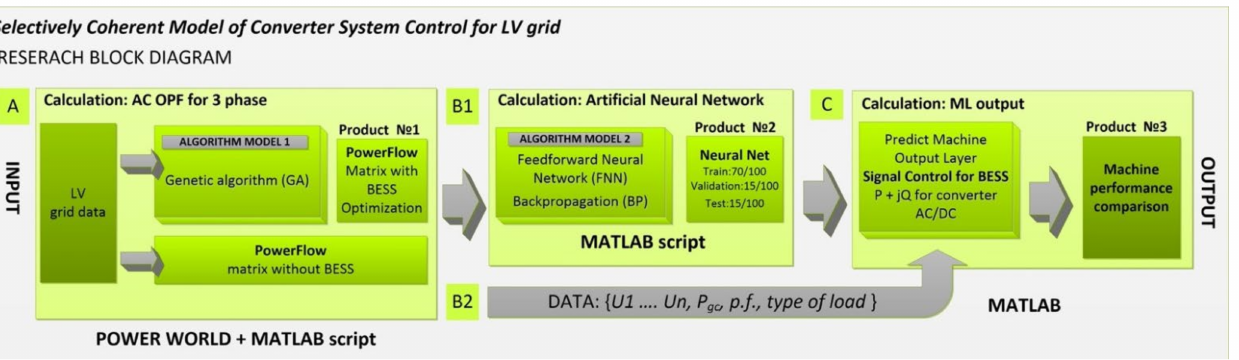
Figure 8. Selectively Coherent Model of Converter System Control for LV grid (Block A : Optimal AC Power Flow for a 3-phase LV grid: Building a database for machine learning using a